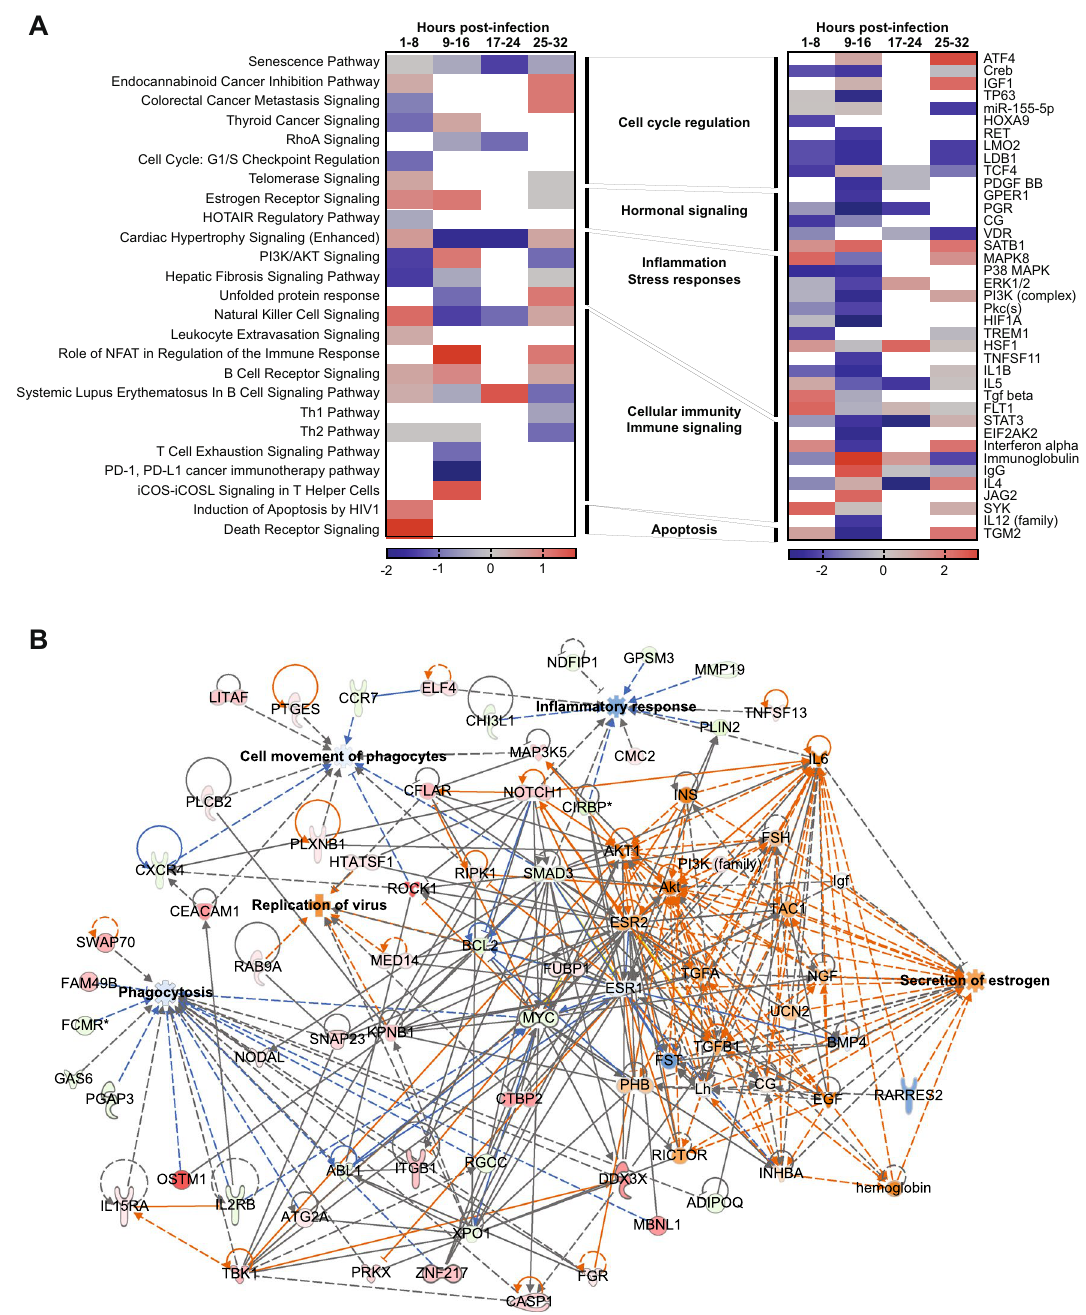
Figure 6. Biological function of molecules associated with virus shedding. ( A ) IPA enriched canonical pathways (left panel) and predicted upstream regulators (right panel) from classifier gene expression in the blood of virus shedders relative to pre-infection controls. Pathways shown had Benjamini–Hochberg-adjusted enrichment p values < 0.05 and activation z scores > | 0.5 | . Heatmap shading indicates z score (red: positive z score, predicted activation; blue negative z score, predicted inhibition; gray: significant enrichment, no predicted activation; white: no significant enrichment). ( B ) IPA molecule activity prediction network showing interactions and predicted activity between genes in different functional categories (phagocytosis, cell movement of phagocytes, inflammatory response, and secretion of estrogen). Molecule shading indicates expression (red: upregulated expression relative to controls; green: downregulated expression relative to controls; orange: predicted upregulation; blue: predicted downregulation). Lines indicate interactions (solid: direct interaction; dashed: indirect interaction; orange: predicted activation; blue: predicted inhibition; gray: no